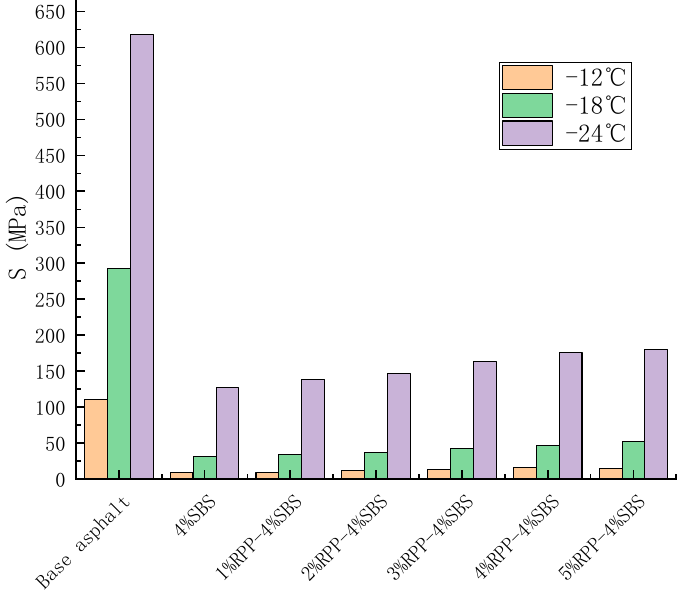
Figure 14. Effect of RPP content on the stiffness modulus of modified asphalt.